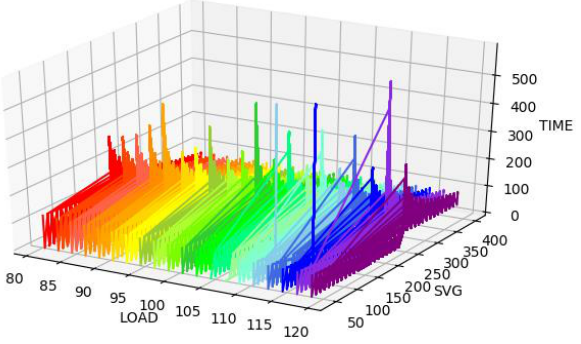
Figure 7. The curve of load rate, SVG compensation, and time of returning to a stable state.